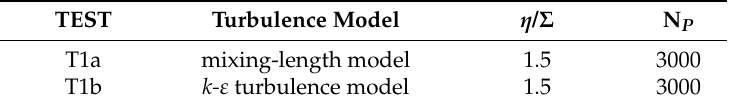
Table 2. Numerical parameters of the SPH simulations in the sensitivity analysis. TEST